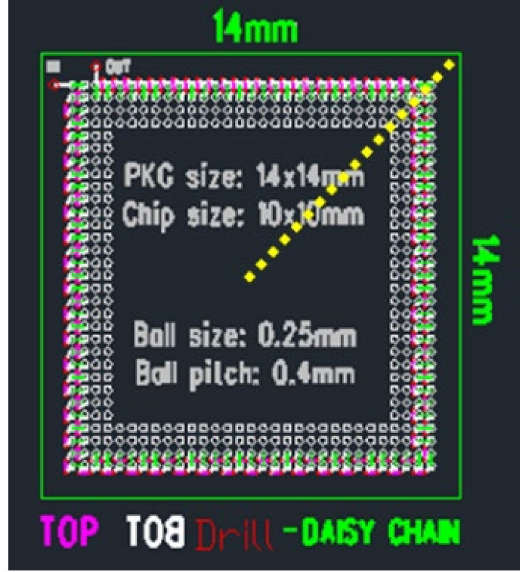
Figure 6. Top view of the test vehicle.